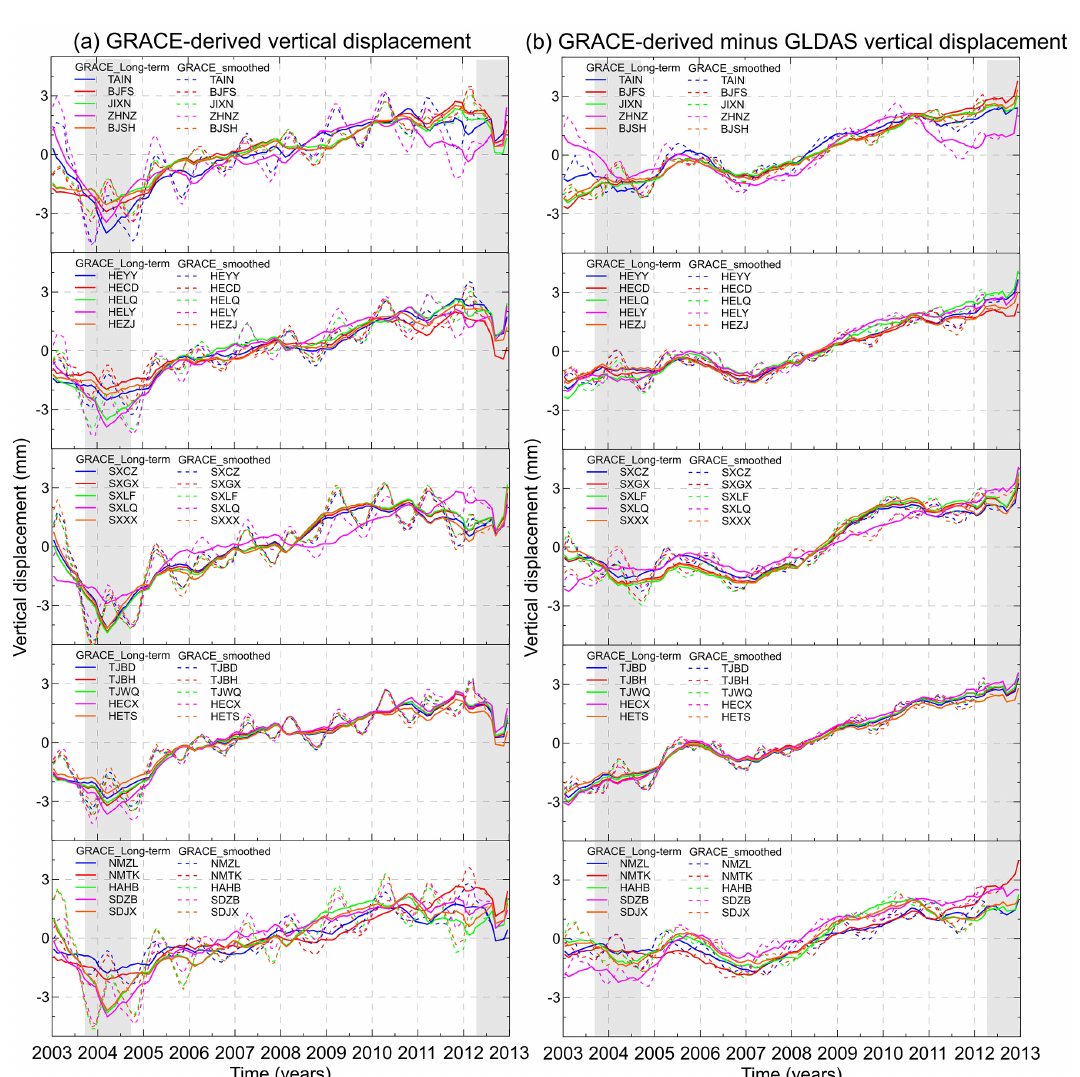
Figure 8. GRACE-derived smoothed (dash curves) and long-term (solid curves) vertical displacement time series due to load changes (a) , the groundwater depletion contributions estimated from GRACE minus GLDAS data for smoothed (dash curves) and long-term (solid curves) vertical displacements (b) , as measured at five IGS stations and 20 CMONOC stations in NCP and its surrounding region. The grey background shows inflexion effects due to TWS changes in the vertical